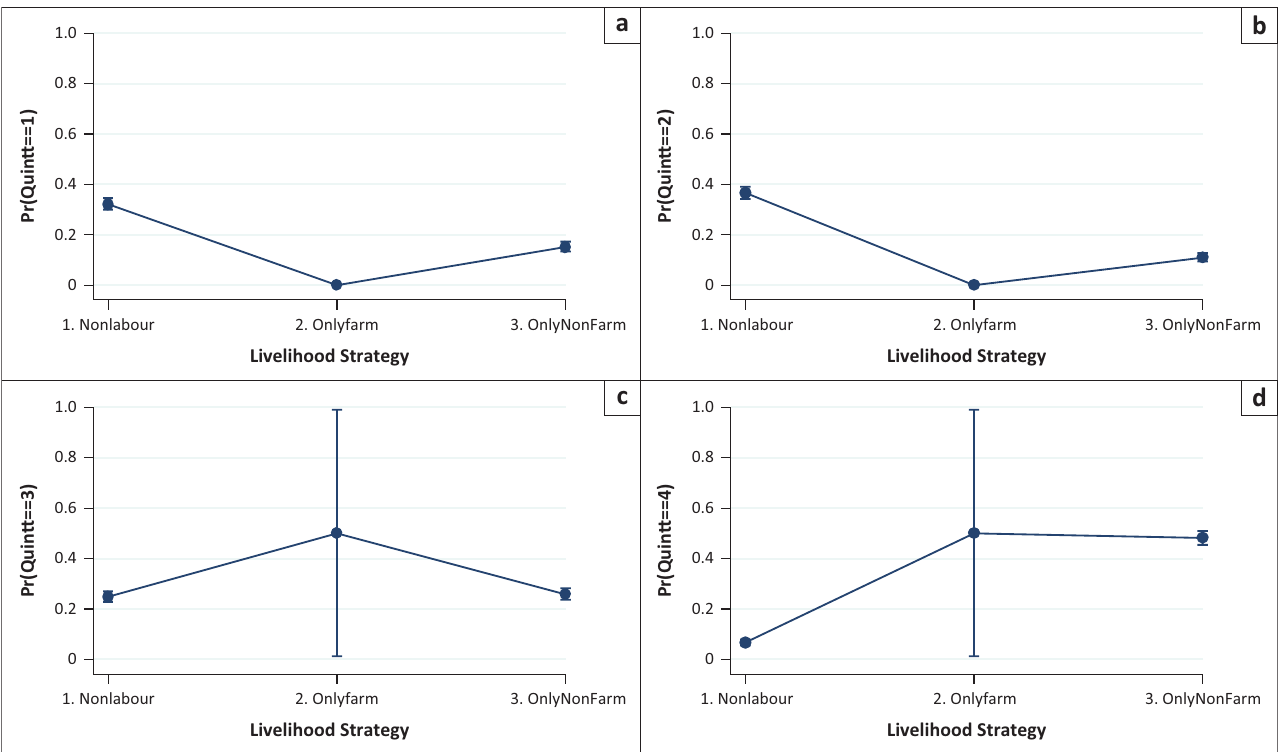
FIG URE 1: Adjusted predictions of strategies with 95 % confidence intervals: (a) First quartile, (b) Second quartile, (c) Third quartile and (d) Fourth